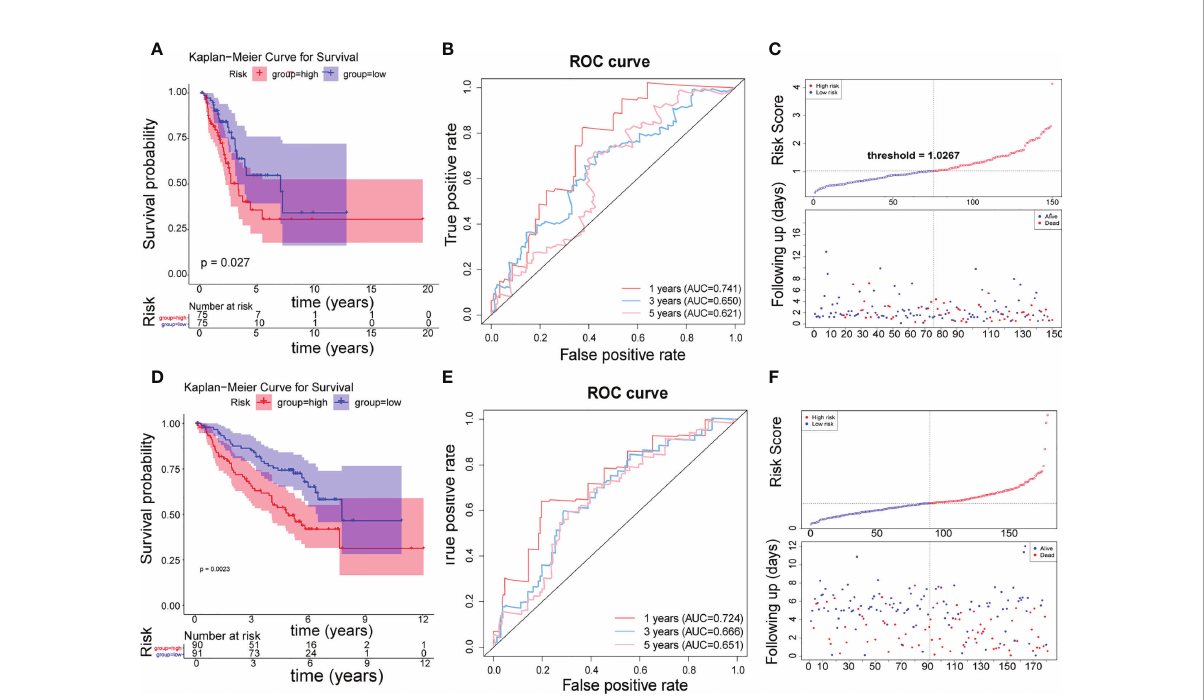
FIGURE 4 Testing and validation of risk features. (A) K – M survival curve of the risk score in the testing set. (B) Time-ROC curve analysis of risk feature in 1, 3,5 years in the testing set. (C) The distribution of risk scores, patient survival status, and survival time in the testing set. (D) K – M survival curve of the risk score in the validation set. (E) Time-ROC curve analysis of risk feature in 1, 3,5 years in the validation set. (F) The distribution of risk scores, patient survival status, and survival time in the validation